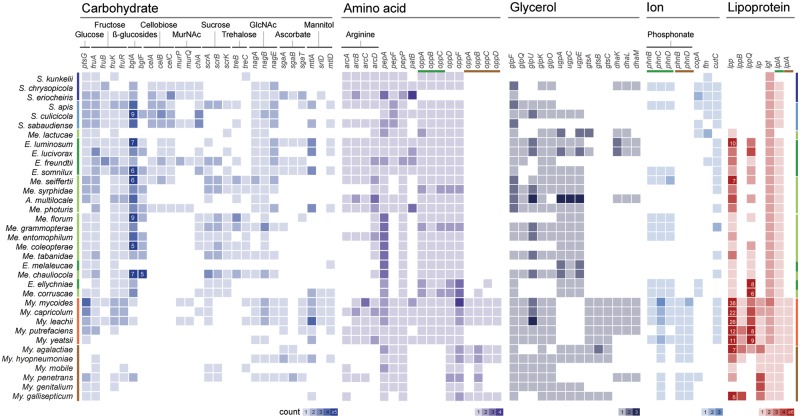
—Presence and absence of genes related to substrate transport, metabolism, and pathogenicity. Three sets of genes could be classified as two distinct types based on sequence similarities among homologous genes (i.e., oppA/B/C/D, phnB/D, and lplA) and the gene names are color-coded (green, Entomoplasmatales-type; brown, Mycoplasmatales-type).